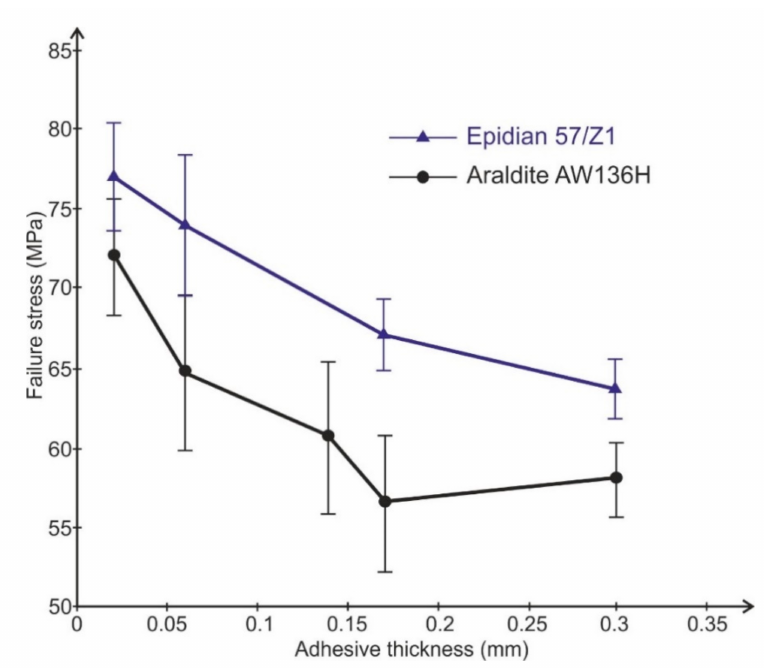
Figure 4. Dependence of adhesive failure stress upon adhesive thickness determined for two